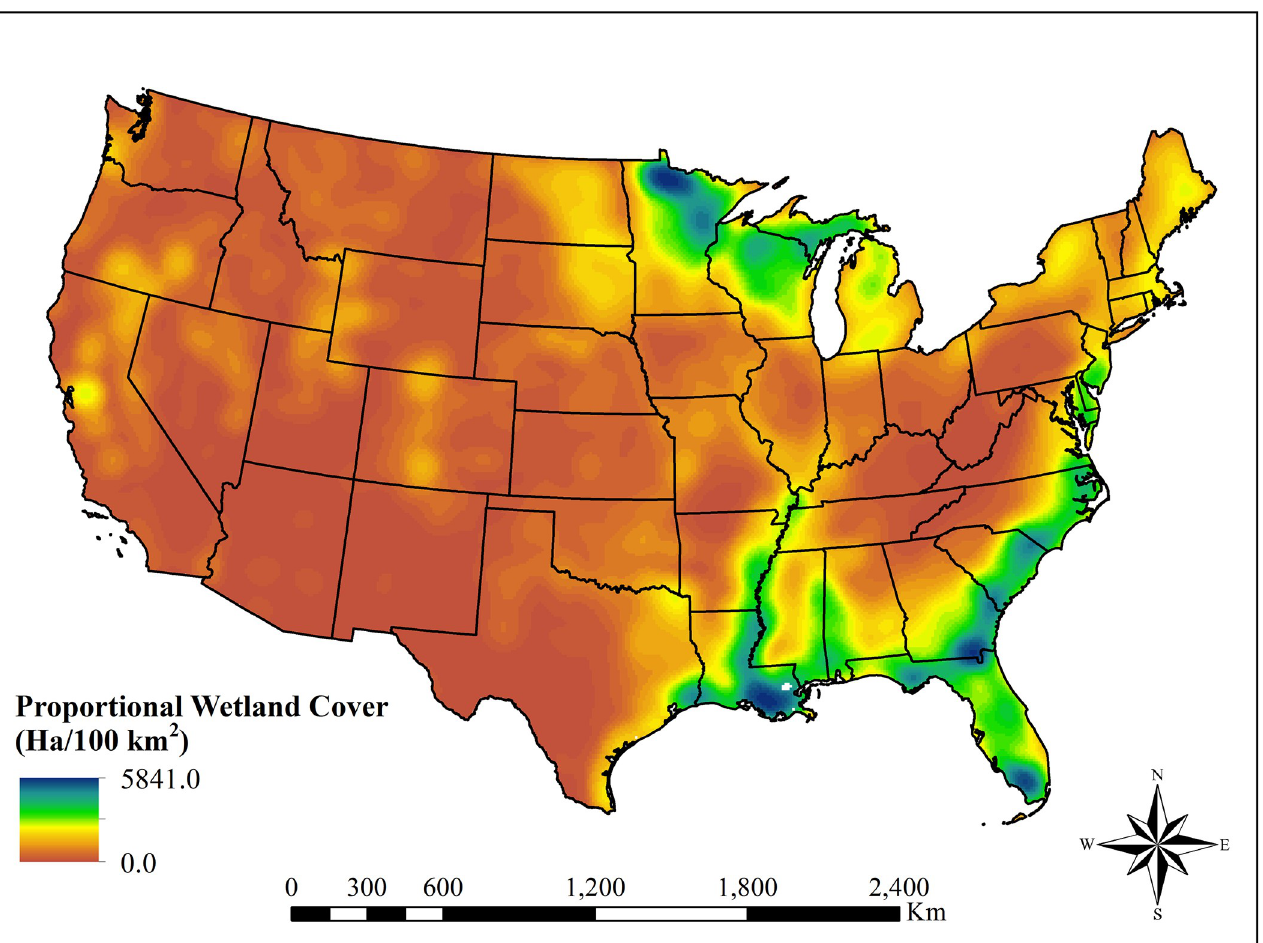
Fig 1. Proportional wetland coverage in the conterminous United States. Proportional wetland cover was derived from the U.S. Fish and Wildlife’s National Wetland Inventory. The highest wetland densities were modeled in Mississippi Alluvial Plain, the Southern Coastal Plain, and northern Minnesota. Coverage values are hectares/100 km 2